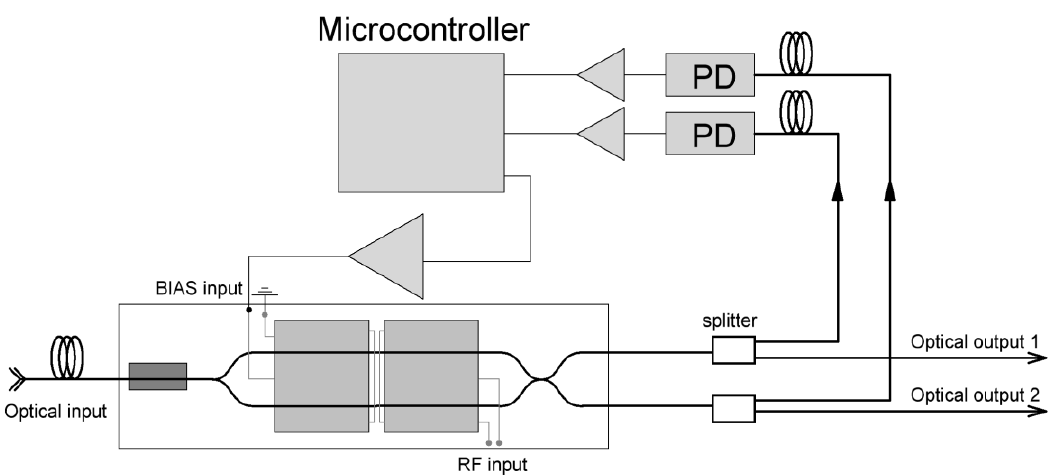
Figure 1. Schematic of stabilization system for operating point for the Mach–Zehnder modulator on lithium niobate substrate with two optical outputs.